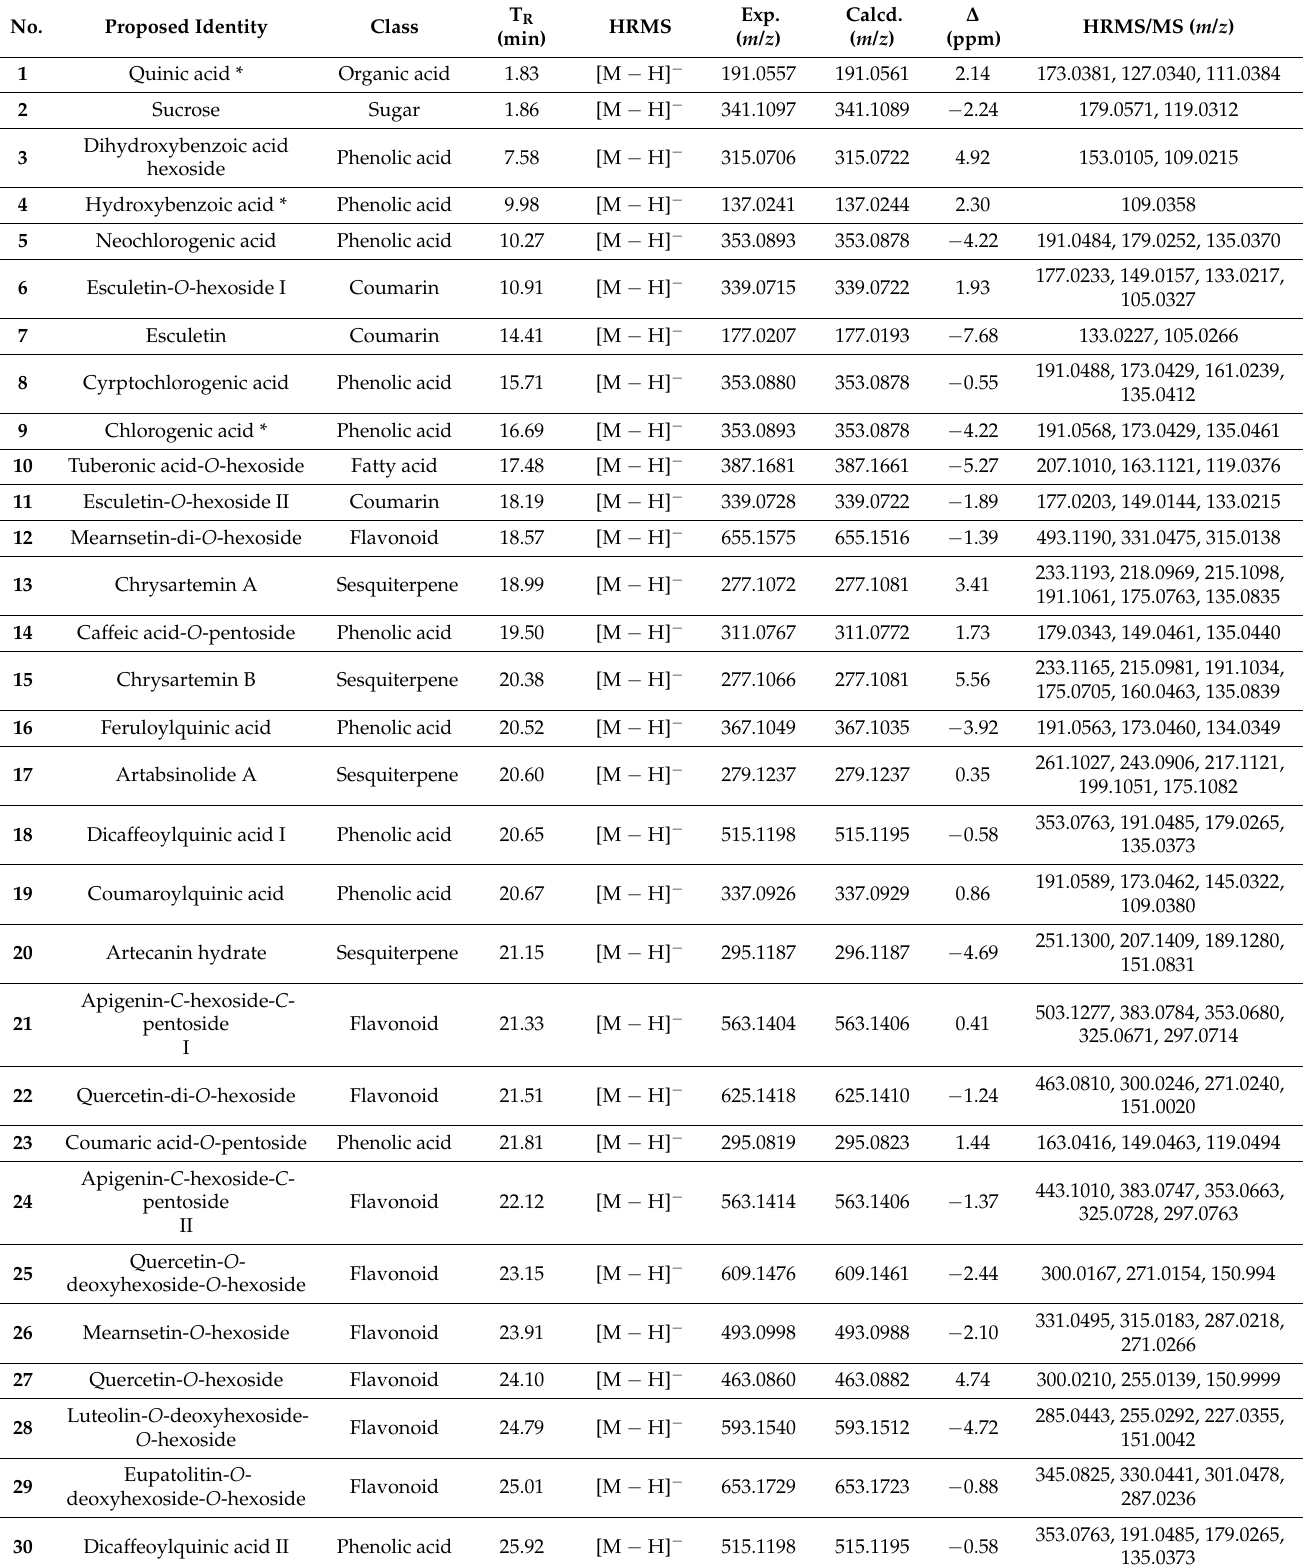
Table 2. LC-HRMS/MS-based phytochemical profiling of Artemisia spp.